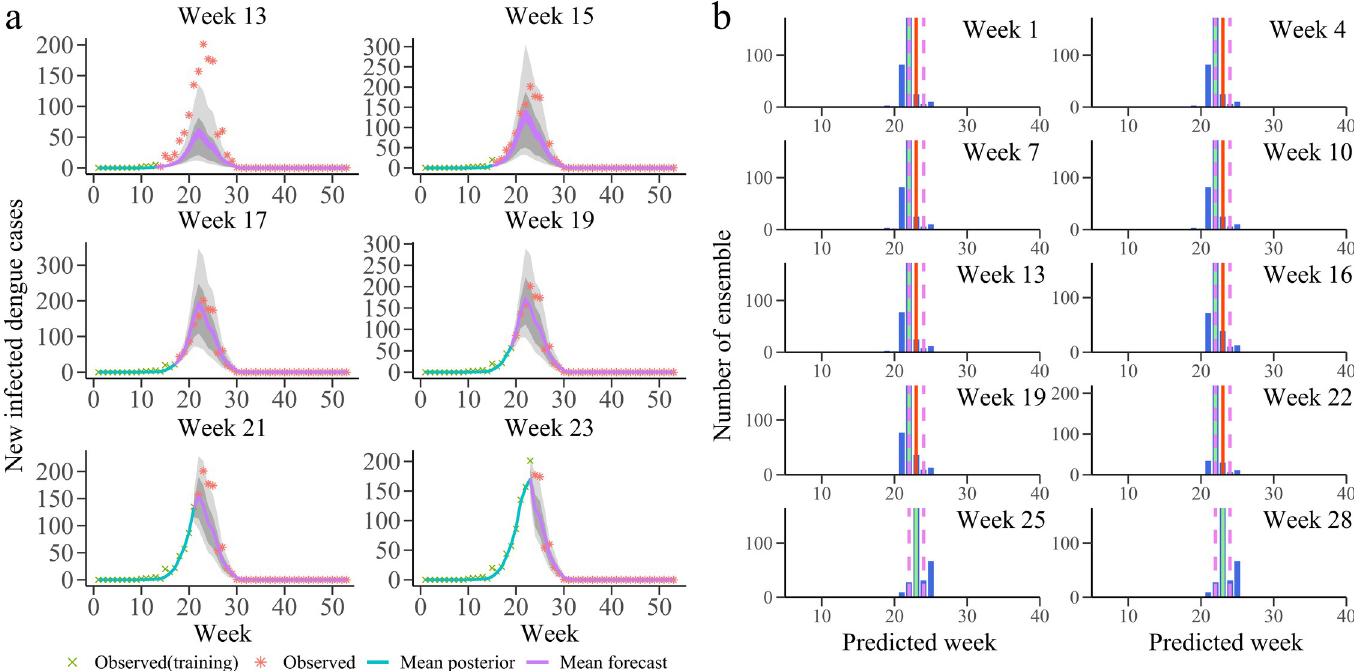
Fig 3. Results of 300-member combined SIR-EAKF retrospective forecasting for 2013–2014 seasons. a Ten bi-weekly forecast of dengue cases for 2013–2014 season. The purple lines are the ensemble mean forecasts, the grey area is the spread of the ensemble forecast (light grey represents area between 10th and 90th percentile and the darker grey area represents the spread between the 25th and 75th percentile), blue lines are the ensemble mean posterior distribution, green cross symbols are data points assimilated into the model and red star symbols are future observations. b Histogram of ensemble forecast peak time for prediction initiated at the end of weeks 1, 4, 7, 10, 13, 16, 19, 22, 25 and 28 week (blue). Also shown are the observed peak (red, week 23) and its ± 1 week (pink) and the ensemble mean (green).